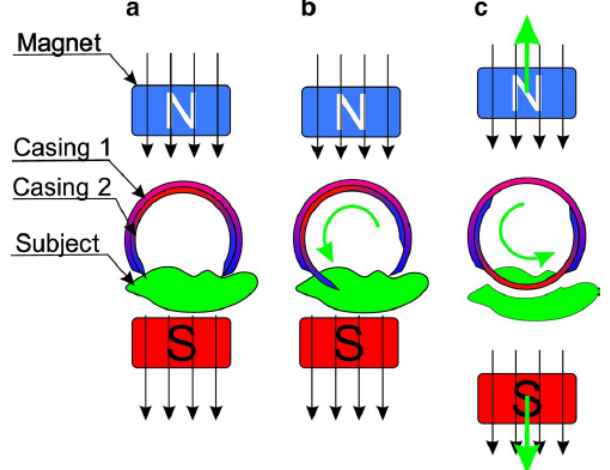
Figure 10. Magnetic torsion spring mechanism for a wireless biopsy capsule. ( a ) Magnetic field applied to bring the device closer to the lesion; ( b ) biopsy process; ( c ) storage of biopsy material. Adapted from Koprowski et al. [71] with permission from